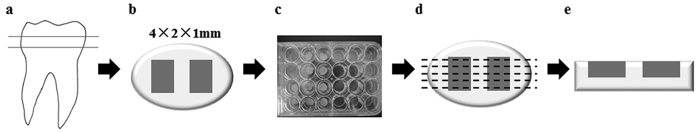
Specimen preparation.(a) Occlusal enamel and roots removed to obtain a 2-mm thick dentin disk; (b) Two class I cavities (width × length × depth was 4 × 2 × 1 mm) were prepared in the dentin disk for different bonding treatments; (c) Sterile specimens were placed into S. mutans emulsions for induction of artificial caries; (d) Specimens were removed from bacteria emulsion and sectioned into slices after designated periods of artificial caries induction; (e) 0.5-mm thick specimen slices were rinsed to remove loosely-attached biofilms for CLSM and SEM.